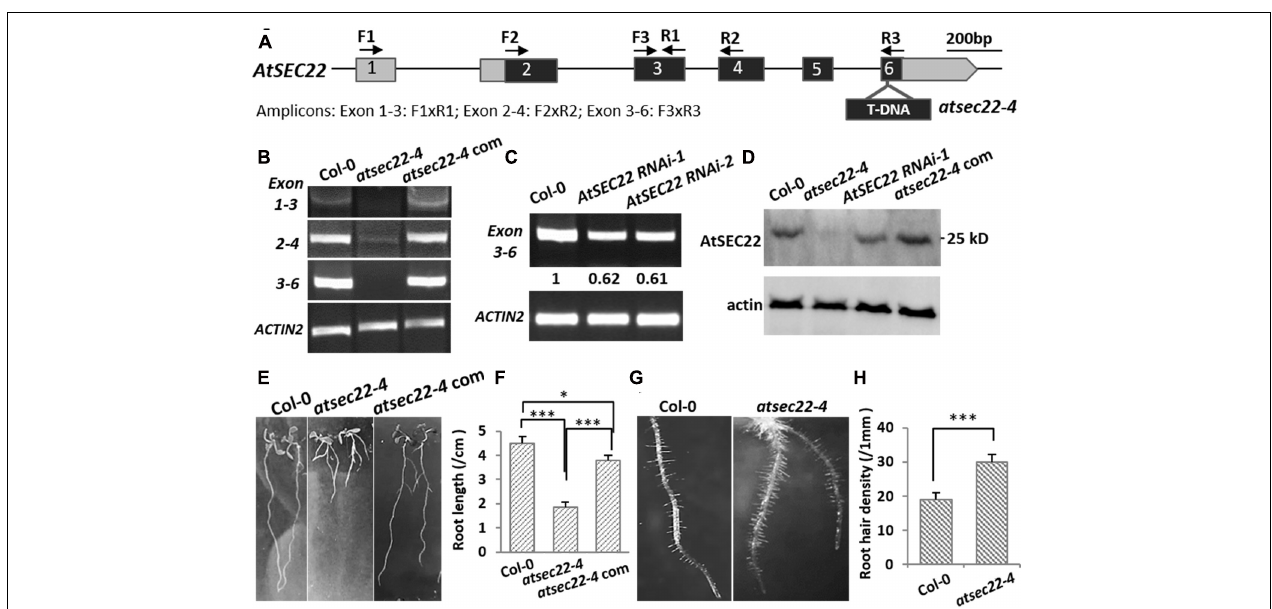
FIGURE 1 | AtSEC22 gene and defective mutants. (A) The structure of AtSEC22 gene and the T-DNA insertion site in atsec22-4 . Location of primers for RT-PCR analysis are indicated by arrows. Exons are indicated by boxes with numbers, and the solid lines indicate introns. (B,C) RT-PCR detection of expression level of AtSEC22 with different combinations of primers in Col-0, atsec22-4, and atsec22-4 complemented lines ( atsec22-4 com). Actin2 was used as endogenous control. Exon 1-3: F1xR1; Exon 2-4: F2xR2; Exon 3-6: F3xR3. (D) Immunoblot was performed with ten-day-old seedlings of Col-0, atsec22-4 , AtSEC22 RNAi, and atsec22-4 complemented lines using the anti-AtSEC22 antibody. (E,F) Ten-day-old seedlings of atsec22-4 exhibited short primary roots and more adventitious roots. Panel (F) shows statistics of panel (E) . n ≥ 30, three independent experiments per sample. (G,H) Root hairs are denser in atsec22-4. Panel (H) shows statistics of panel (G) . n ≥ 10 roots. *** P < 0.001. Significance was evaluated by Student’s t test.